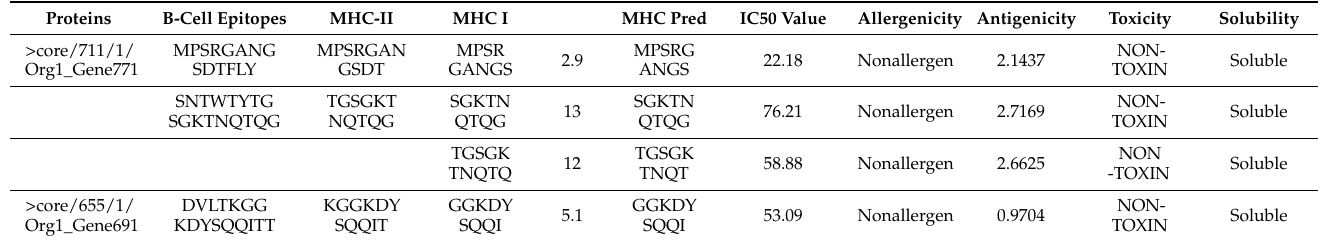
Table 2. Epitope prioritizations using different filters to select epitopes having the potential to be part of the vaccine